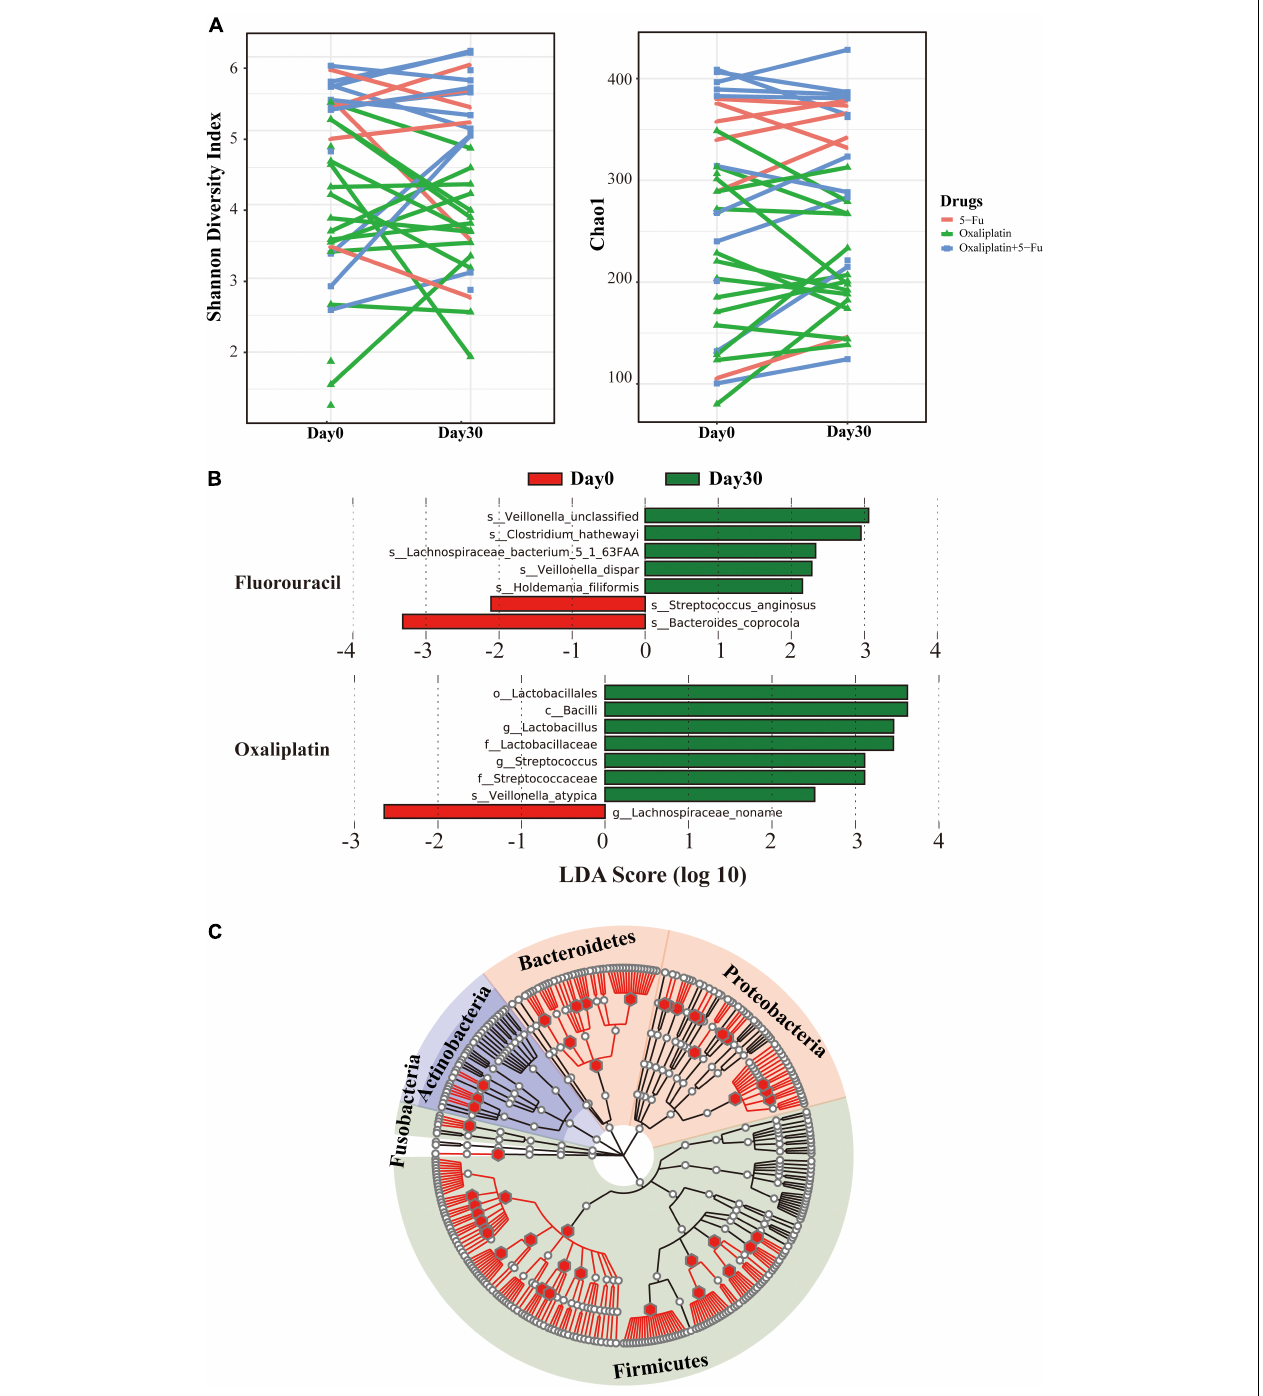
FIGURE 1 | Gut microbial diversity before and after the chemotherapy. (A) Shannon diversity (left) and Chao (right) based on 16 S rRNA sequencing. Different colors stand for drugs: red for 5-fluorouracil, green for oxaliplatin, and blue for 5-fluorouracil and oxaliplatin. The y -axis stands for the collection time. (B) Cladogram derived from LEfSe analysis of metagenomic sequences based on the shotgun sequencing comparing day 0 with day 30. Green shaded areas indicate microbe orders that more consistently describe the fecal microbiome from day 30; red shaded areas indicate microbe orders that more consistently describe from day 0. The prefixes “c,” “o,” “f,” “g,” and “s” represent the annotated level of class, order, family, genus, and species. (C) Comparison of 16 S rRNA and metagenome abundances. The tree represents all taxonomically classified species from the shotgun metagenome survey as well as 16 S rRNA sequence. The branches of the tree do not reflect evolutionary distances. The position of the dots in the tree corresponds to the taxonomic placement of the representative sequences in the NCBI taxonomy. Empty dots represent the phylotypes found in the shotgun metagenome classification; red dots were identified from both methods.